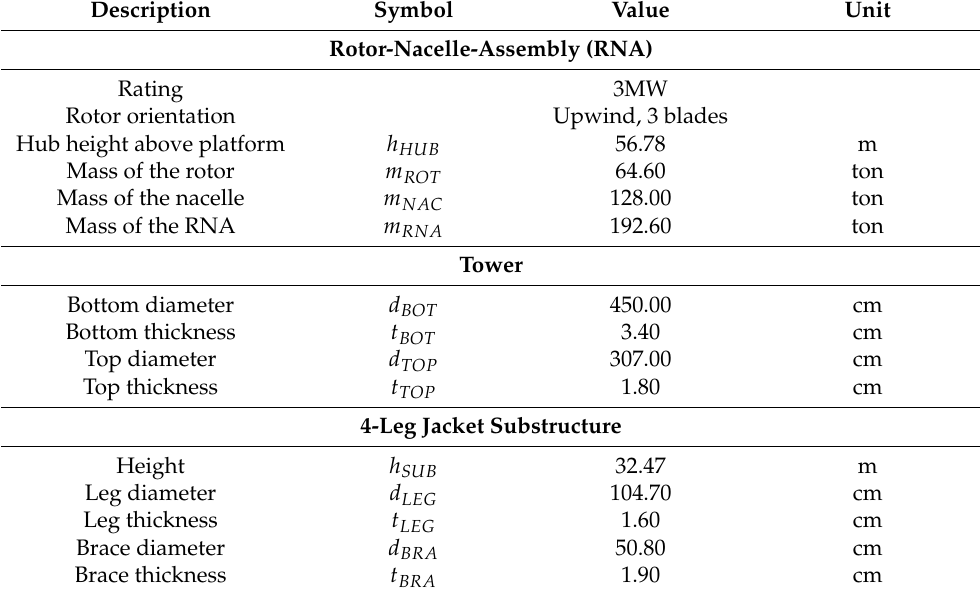
Figure 1. A 3MW offshore wind turbine selected for the study: ( a ) Site location; ( b ) A 3MW jacket substructure. Table 1. Geometrical and mechanical details of the 3MW offshore wind turbine.